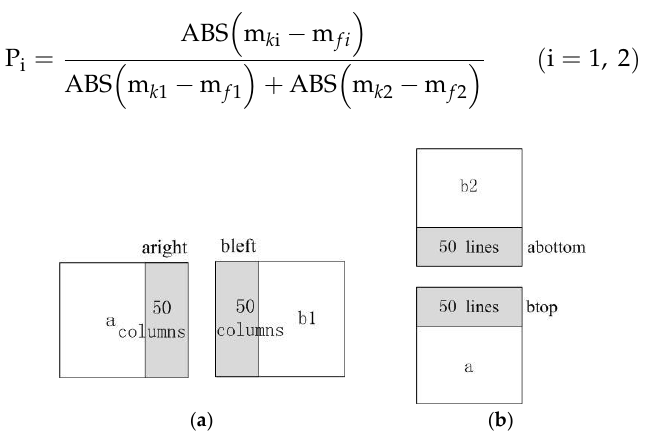
Figure 4. Parameter calculation: ( a ) left and right overlapping diagram and ( b ) upper and lower overlapping diagram.